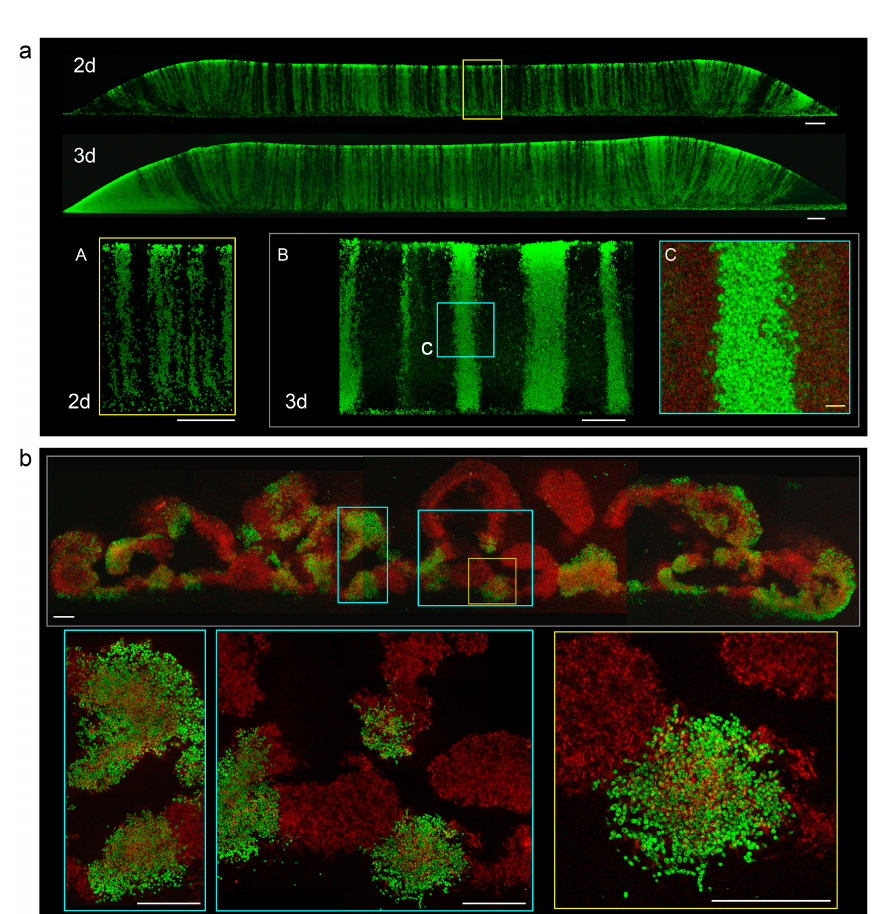
Figure 1. Vertical cross-sections of chimeric smooth colonies and colony biofilms. ( a ) Cross-sections visualized by two photon confocal microscopy (2PE-CM) of 2-day-old and 3-day-old chimeric giant colonies of strains BY4742 (black stripes) and BY-p TEF -GFP (green stripes), mixed equally, and inoculated as 1 μ l drops of 10 8 cells/mL. Lower panel, details of stripes in higher magnification, of 2-day-old colony as above (A) and from 2-day-old colony inoculated by 1 μ l drops of 10 6 cells/mL (B and inset C). White bar, 100 μ m, yellow bar, 10 μ m. ( b ) Cross-sections of chimeric giant colony biofilm formed by biofilm-forming cells (BR-F) and BR-F-p TEF -GFP mixed equally and inoculated as 1 μ l drops of 10 8 cells/mL. Here, the autofluorescence of “black” BR-F cells is visualized as a false red color. The cell-free areas filled with extracellular matrix (ECM) are black. Insets show parts of the colony biofilm in higher magnification. Bar, 100 μ m.